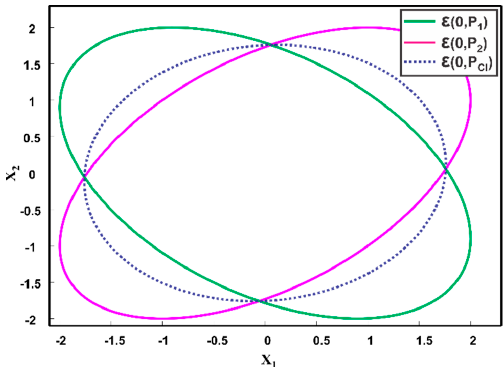
Figure 8. Two estimates at the origin, i.e., ε ( 0, P 1 ) , ε ( 0, P 2 ) and their fused result ε ( 0, P CI ) , provided by Covariance Intersection method.